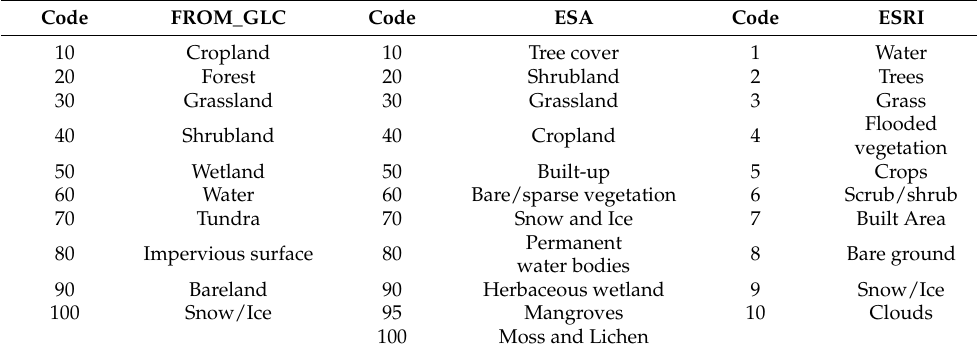
Table 2. Original classification systems and codes for different land cover